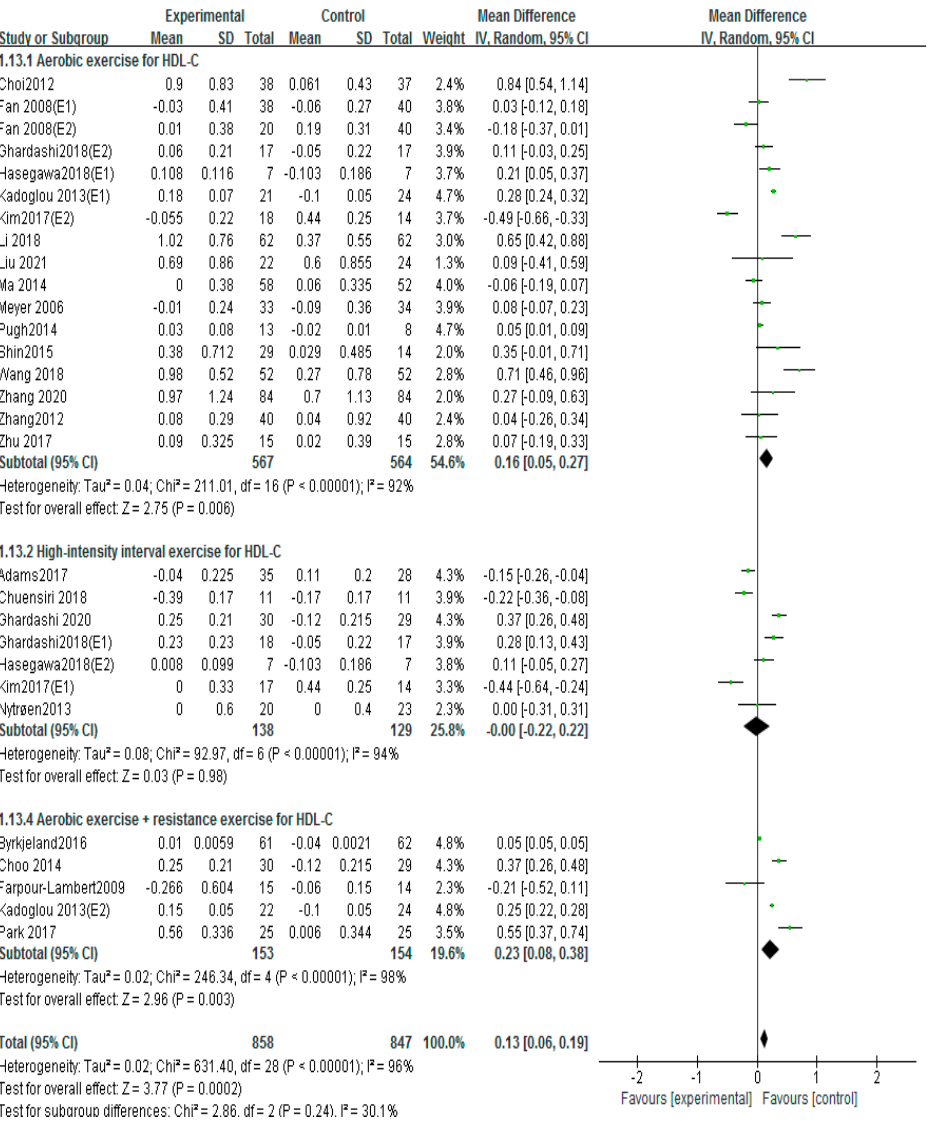
Figure 11. Subgroup analysis of HDL − C effect size under different modes of exercise [12,13,16–19,21–29,31,32,34–36,39,42,43].